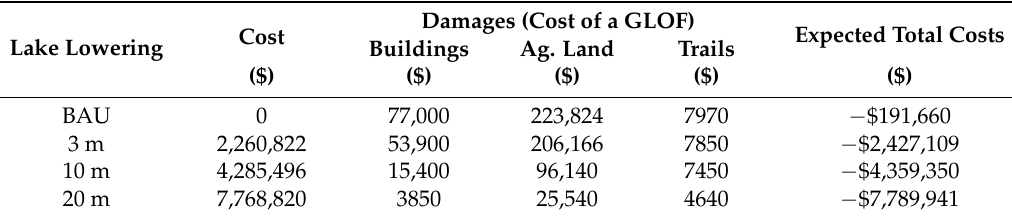
Table 6. Expected total costs of potential lake lowering projects relative to the 0-m lowering case using baseline parameter values (probability of flood = 0.50, time to GLOF = 15 years, inflation rate = 9.1%, discount rate = 6%).